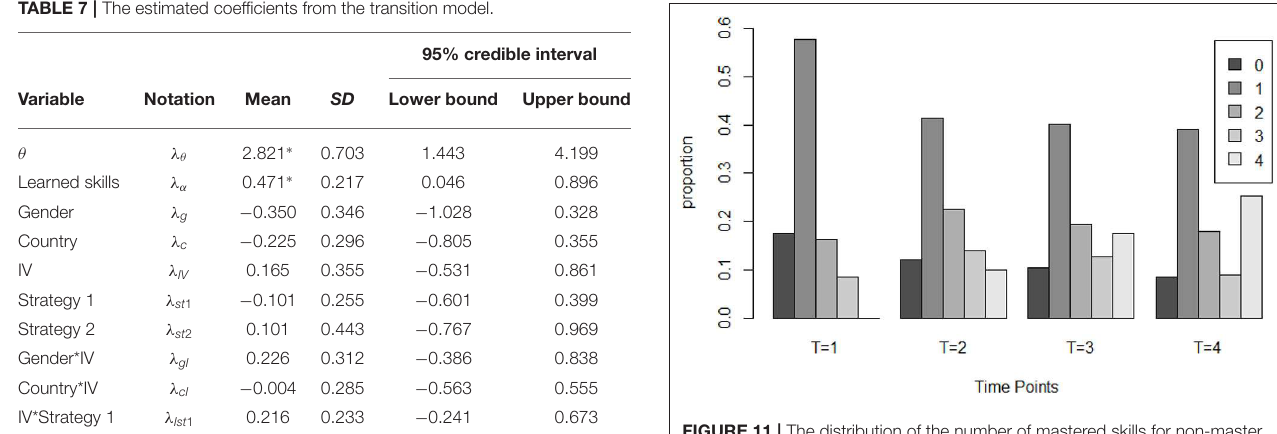
FIGURE 11 | The distribution of the number of mastered skills for non-master group at four time